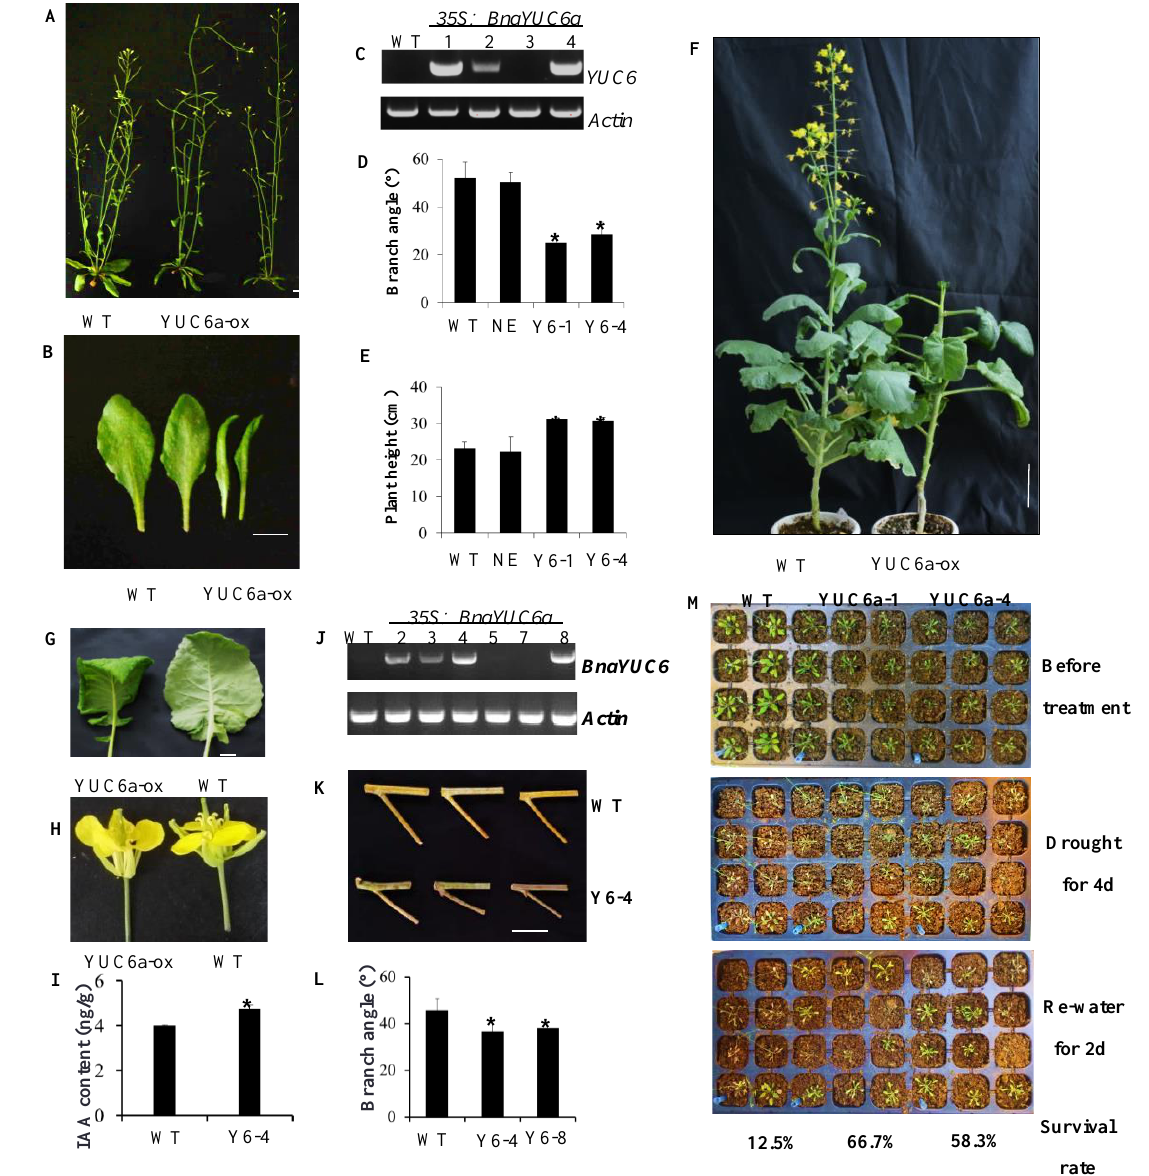
Figure 5. BnaYUC6a -overexpressing plants changed in plant architecture and drought resistance.